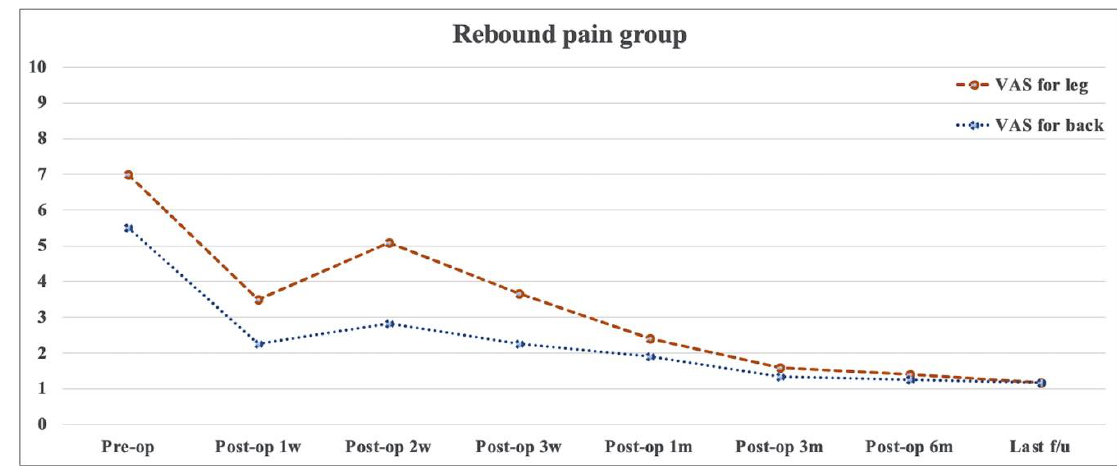
Figure 2. Changes in visual analog scale scores with time in the non-rebound pain group.